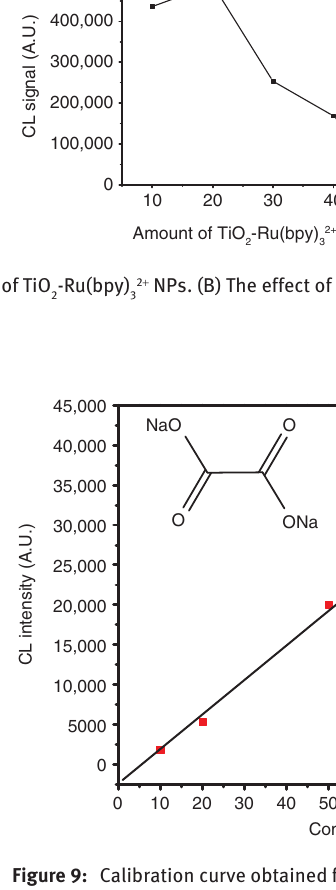
Figure 9: Calibration curve obtained for sodium oxalate using diluted TiO -Ru(bpy) 32 + NPs. 2 Conditions: 0.5 mm Ce(IV) and 200 ml/h flow rate. The oxalate structure is also